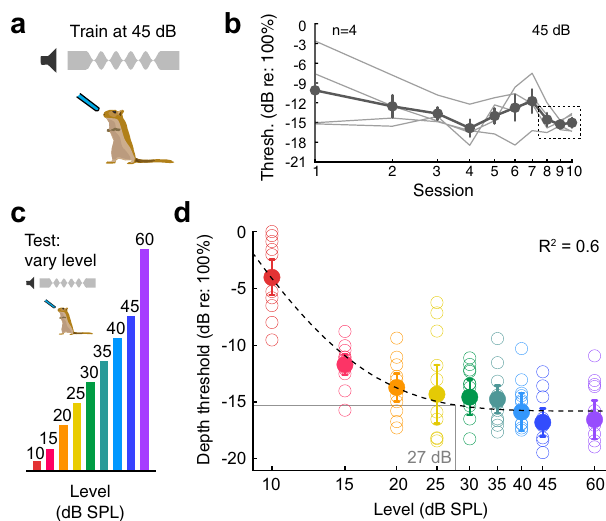
Fig. 9 Control experiment: AM depth detection thresholds remain stable across relevant sound levels. a Adult animals ( n = 4) were trained on the AM depth detection task at 45 dB SPL. b Depth detection thresholds across 10 psychometric testing days. Thin lines indicate individual data, and circles with associated error bars indicate mean ± SEM. Once detection thresholds stabilize (i.e., consistent for three consecutive sessions: dotted rectangle), then the sound level was varied from 10-60 dB SPL ( c ). d Behavioral AM depth detection thresholds across sound level (dB SPL). Open circles indicate individual performance (3 sessions per animal, 4 animals total) and solid circles indicate the group mean (±SEM). A 3-parameter exponential was fi t to the data (dotted line). Thresholds asymptote at − 15.8 dB (re: 100% AM), which corresponds to 27 dB SPL. Therefore, depth detection thresholds remain consistent for sound levels greater than 27 dB function and degraded AC population encoding during task